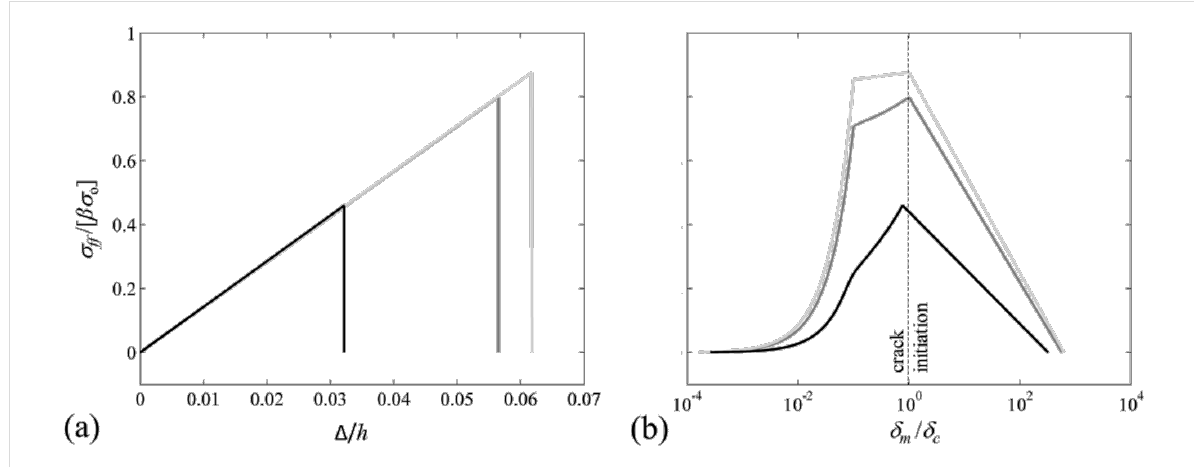
Figure 3: Average tensile stress at the tip of the fiber (a) as a function of normalized far field displacement Δ / h , and (b) as a function of normalized maximum interfacial separation δ m / δ c for β = 1.2 and θ = 25° (dark gray), θ = 45° (light gray), and θ = 75° (black). Here, δ c = 1 nm ( χ = 6). Peaks in each plot for specific θ coincide and correspond to normalized pull-off stress Φ . Tensile load drops immediately after the maximum interfacial sep- aration reaches the critical separation indicating that the contact is unstable following crack initiation. The discontinuity at δ m / δ c ≈ 0.1 prior to crack initiation in (b) marks the instant when a cohesive zone starts to form.